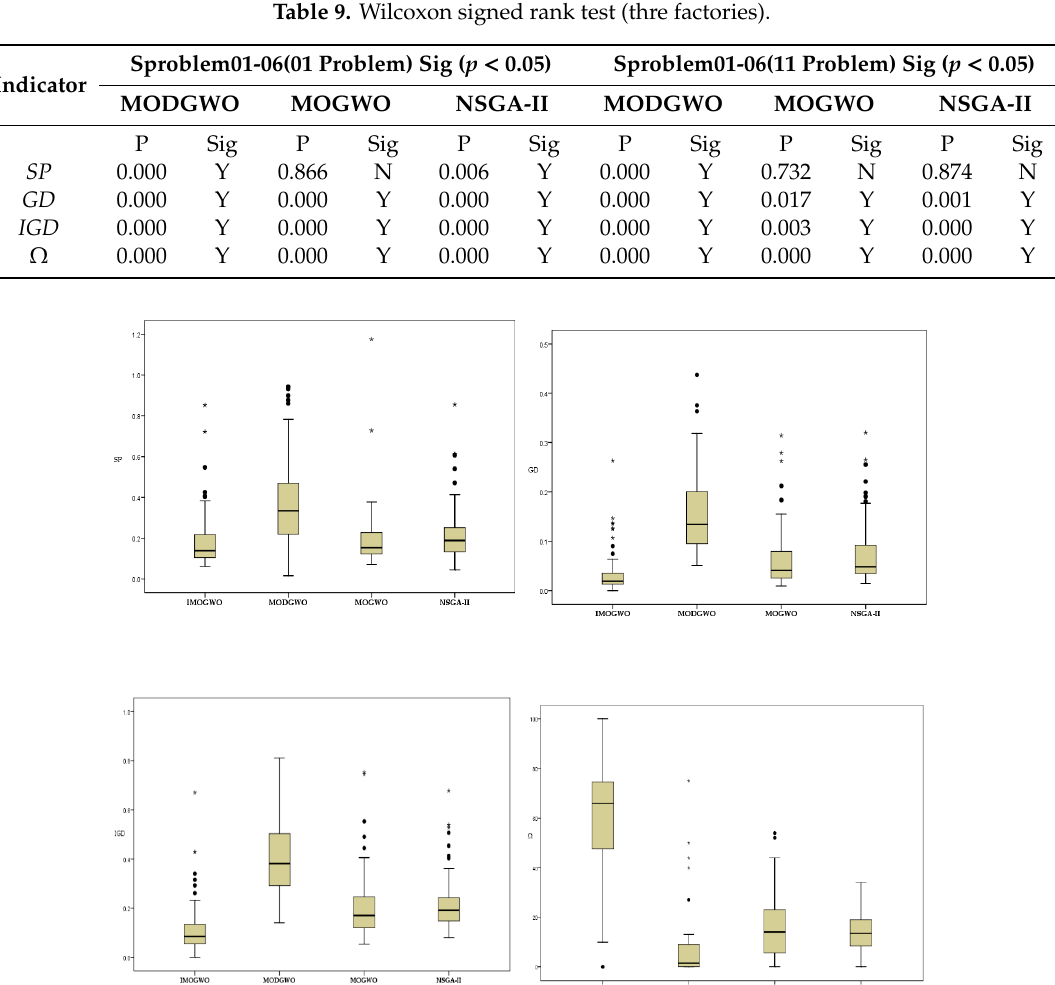
Figure 6. Box-plots of four evaluation indicators for three factories’ test